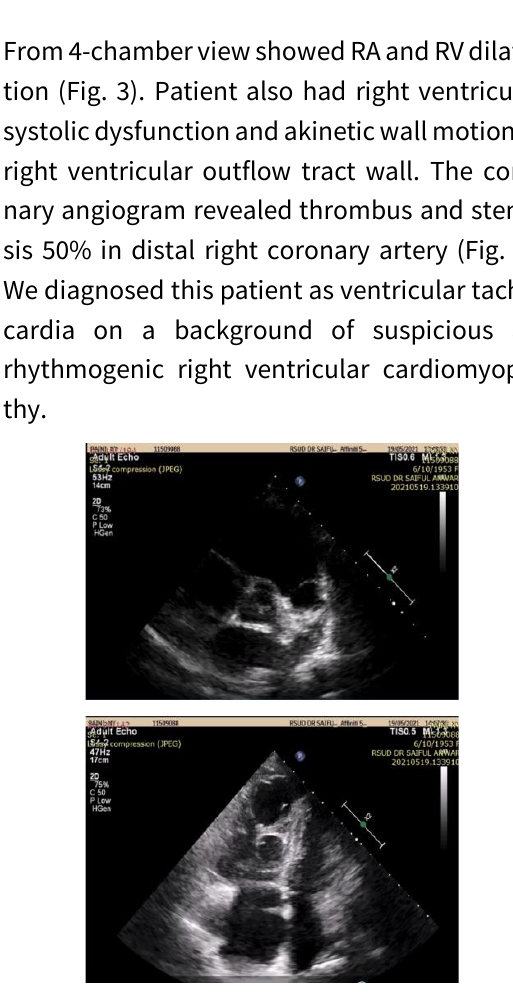
Figure 3. Parasternal short-axis view of echocardiog- raphy showing severe right ventricular dilatation. From 4- chamber view showed RA and RV dilatation